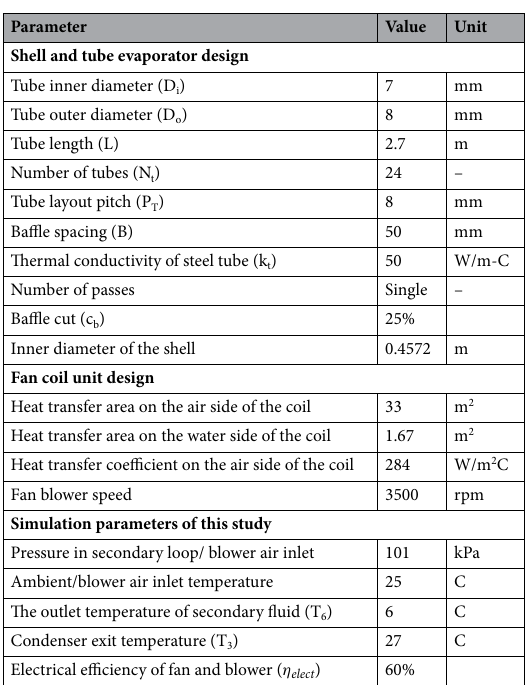
Table 3. Dimensions and simulation parameters used in this